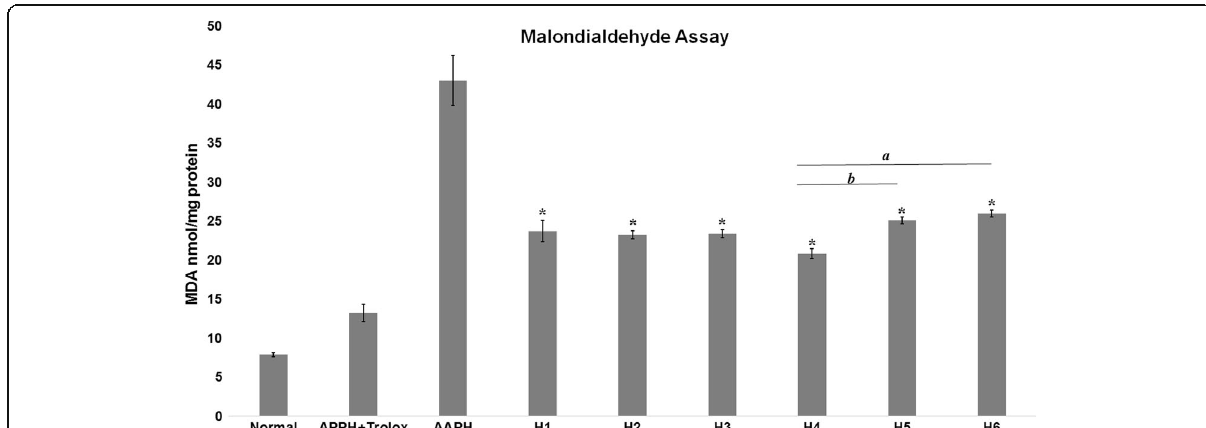
Fig. 1 Malondialdehyde content measured by TBARS assay in erythrocytes after treatment. Data expressed as nmol MDA/mg protein. Normal represented the amount of MDA in erythrocytes without treatment. Normal and AAPH + Trolox were used as positive controls for the experiment. Comparisons using Post Hoc Tukey test was carried out for AAPH, H1, H2, H3, H4, H5, and H6. *Significant decrease in MDA levels compared to AAPH treated group. a - Significant difference in MDA levels between H4 and H6. b - Significant difference between H5 and H6